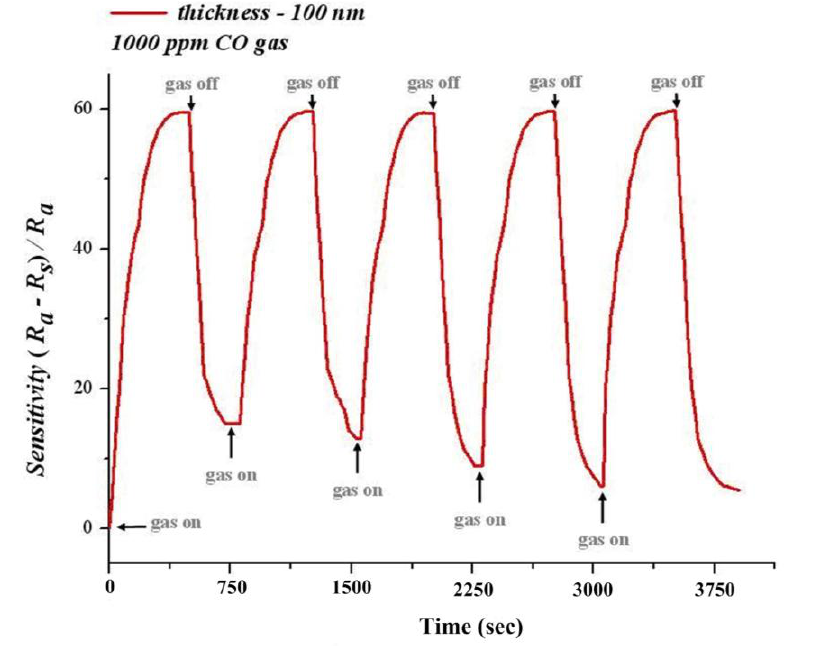
Figure 12. Stability testing in 1,000 ppm of CO (T = 270